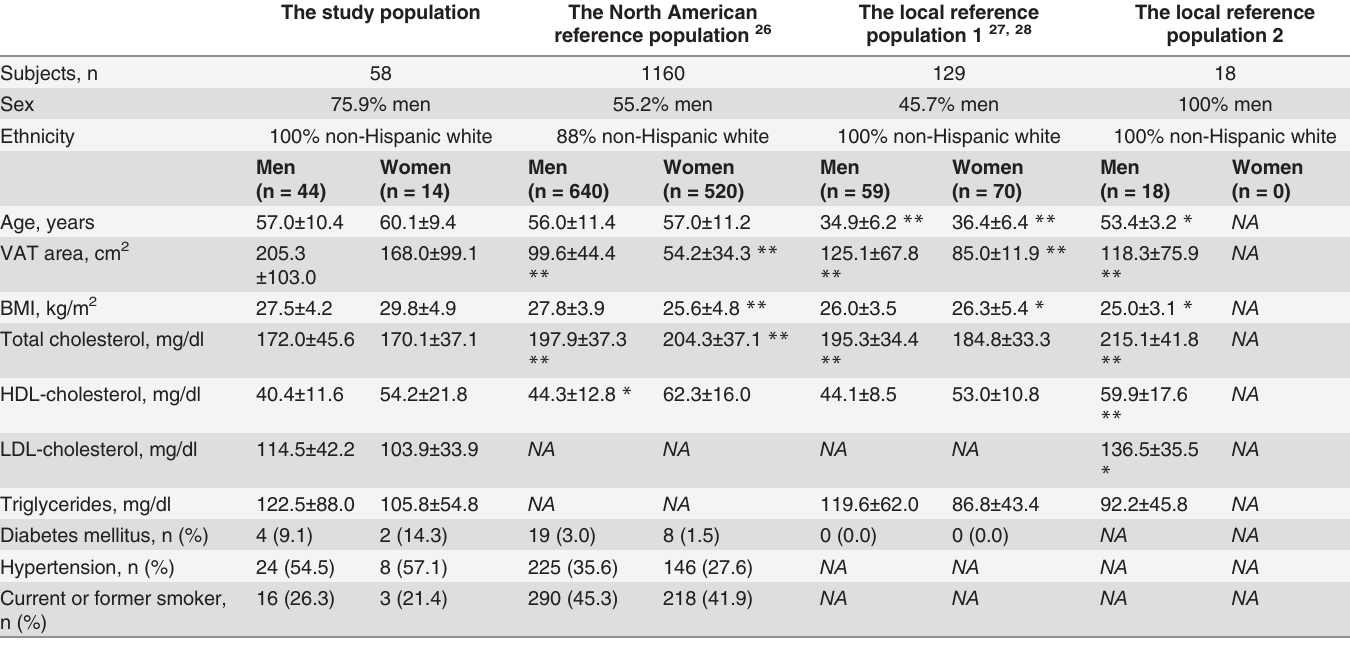
Table 1. Clinical characteristics of the study population and the reference populations. The study